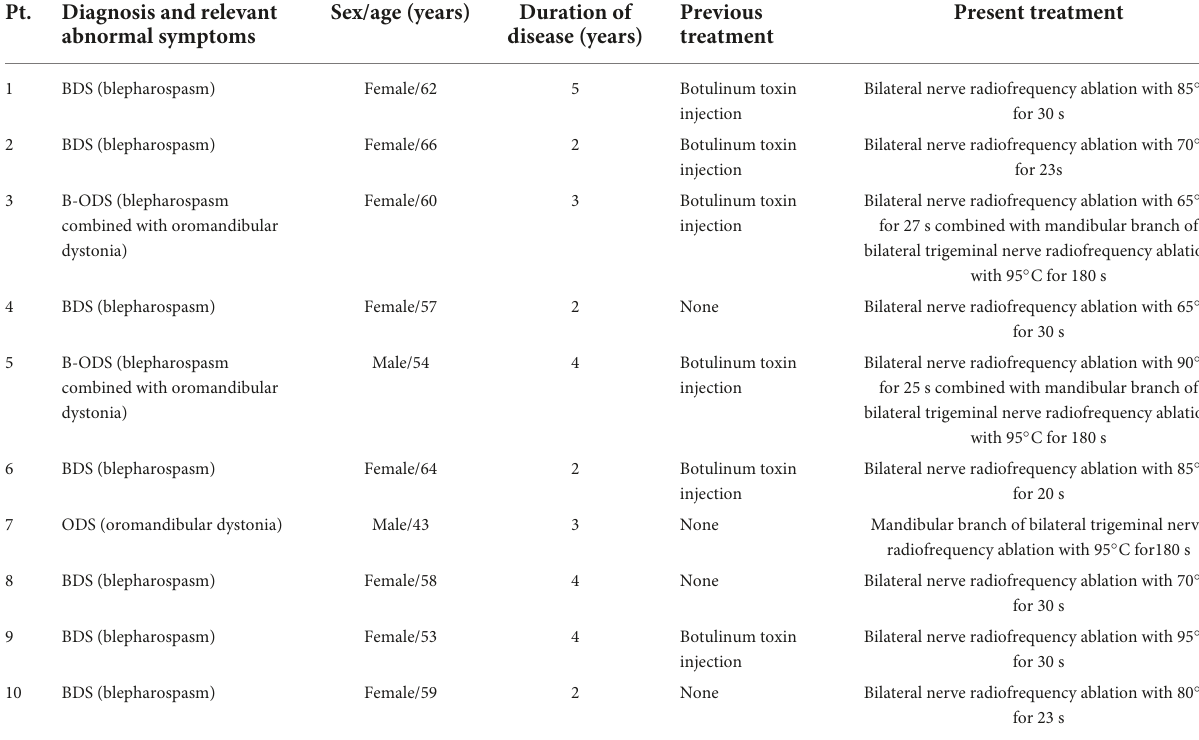
TABLE 1 Characteristics and treatments of study patients. Pt.